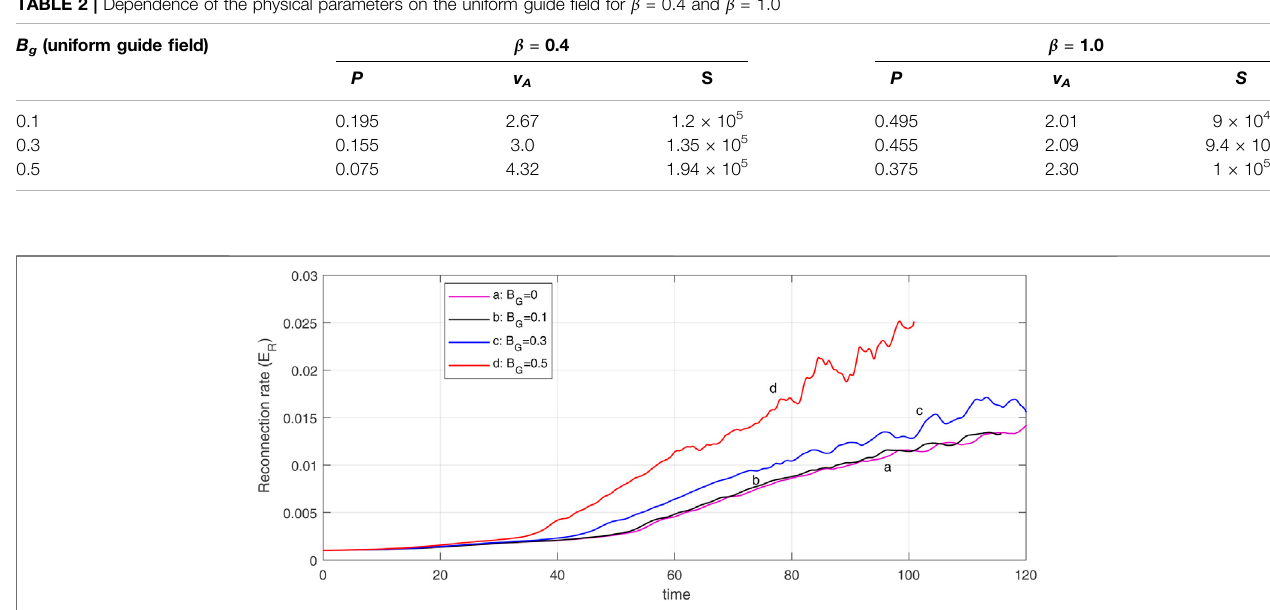
FIGURE 5 | Time variation of magnetic reconnection for different values of B g for β (cid:1) 0.4.